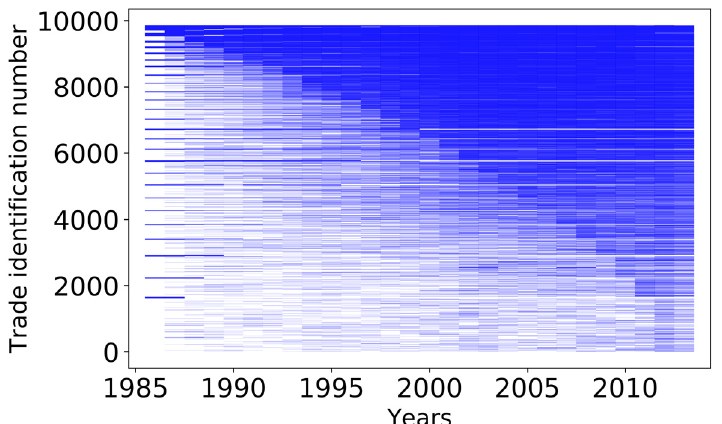
Fig 3. Time series of trades in the intermediate subnetwork. This graph shows the activity for the 9858 trade exchanges belonging to the intermediate subnetwork i.e . trades with duration comprised between 3 and 27 consecutive years. If the blue line is continuous then the trade has no interruption. Trades are sorted according to their cumulative lifetime starting from the shortest cumulative periods. The distribution of the continuous duration of trades is heterogeneous and only a minority of trades last during the maximum duration of 27 consecutive